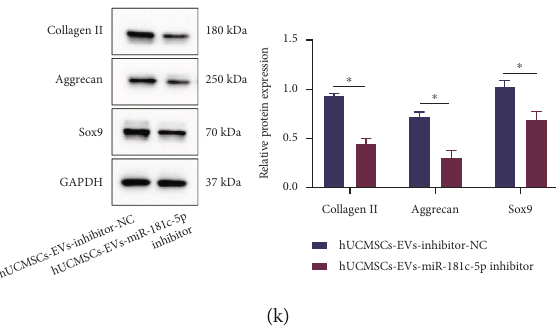
Figure 3: E ff ect of hUCMSC-EVs carrying miR-181c-5p on the proliferation, migration, and cartilage di ff erentiation of BMSCs. (a) Heat map of expression of the top 30 miRNAs with the smallest p values in GSE99736. Color scale (blue to orange) indicates expression values from small to large ( n = 3 ). (b) miR-181c-5p expression in hUCMSCs and their secreted EVs was determined by RT-qPCR. (c) miR-181c-5p expression in BMSCs after coincubation of hUCMSC-EVs was determined by RT-qPCR. (d) The fl uorescence after treatment of Cy3-labeled hUCMSC-EV-miR-181c-5p ( scale bar = 25 μ m ). (e) RT-qPCR for miR-181c-5p expression in hUCMSC-EVs. BMSCs were coincubated with hUCMSC-EVs transduced with the miR-181c-5p inhibitor. (f) miR-181c-5p expression in BMSCs was determined by RT-qPCR. (g) Proliferation of BMSCs was detected by the CCK8 assay. (h) Migration of BMSCs was detected by the Transwell assay ( scalebar = 50 μ m ). (i) Cartilage di ff erentiation ability of BMSCs was detected by Alcian blue staining ( scalebar = 50 μ m ). (j) mRNA levels of collagen II, aggrecan, and Sox9 in BMSCs were determined by RT-qPCR. (k) Protein levels of collagen II, aggrecan, and Sox9 in BMSCs were measured by Western blot analysis. ∗ p < 0 : 05 . All experiments were repeated for three